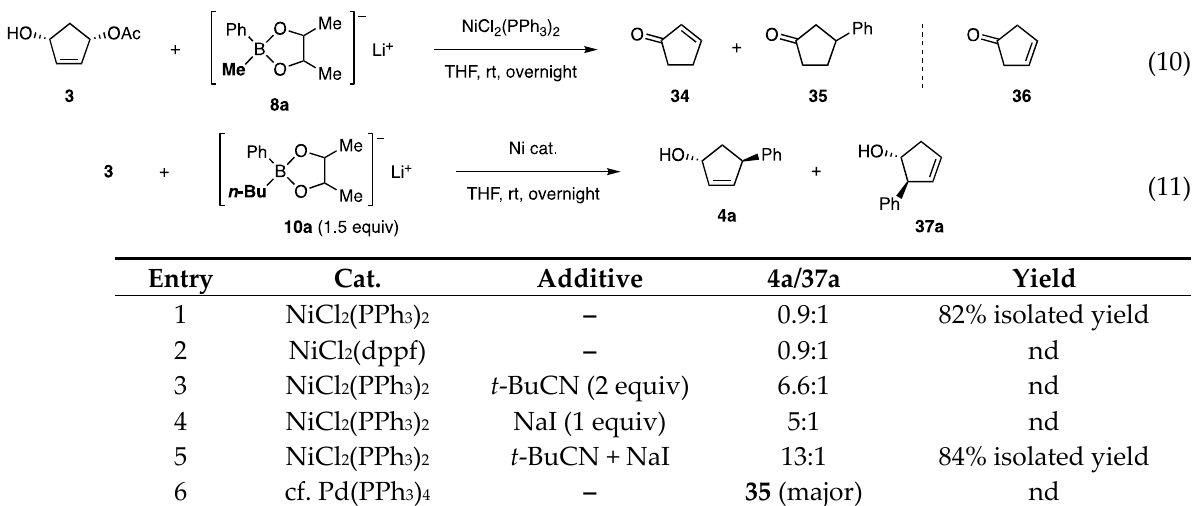
Figure 3. Coupling products derived from zinc borates.